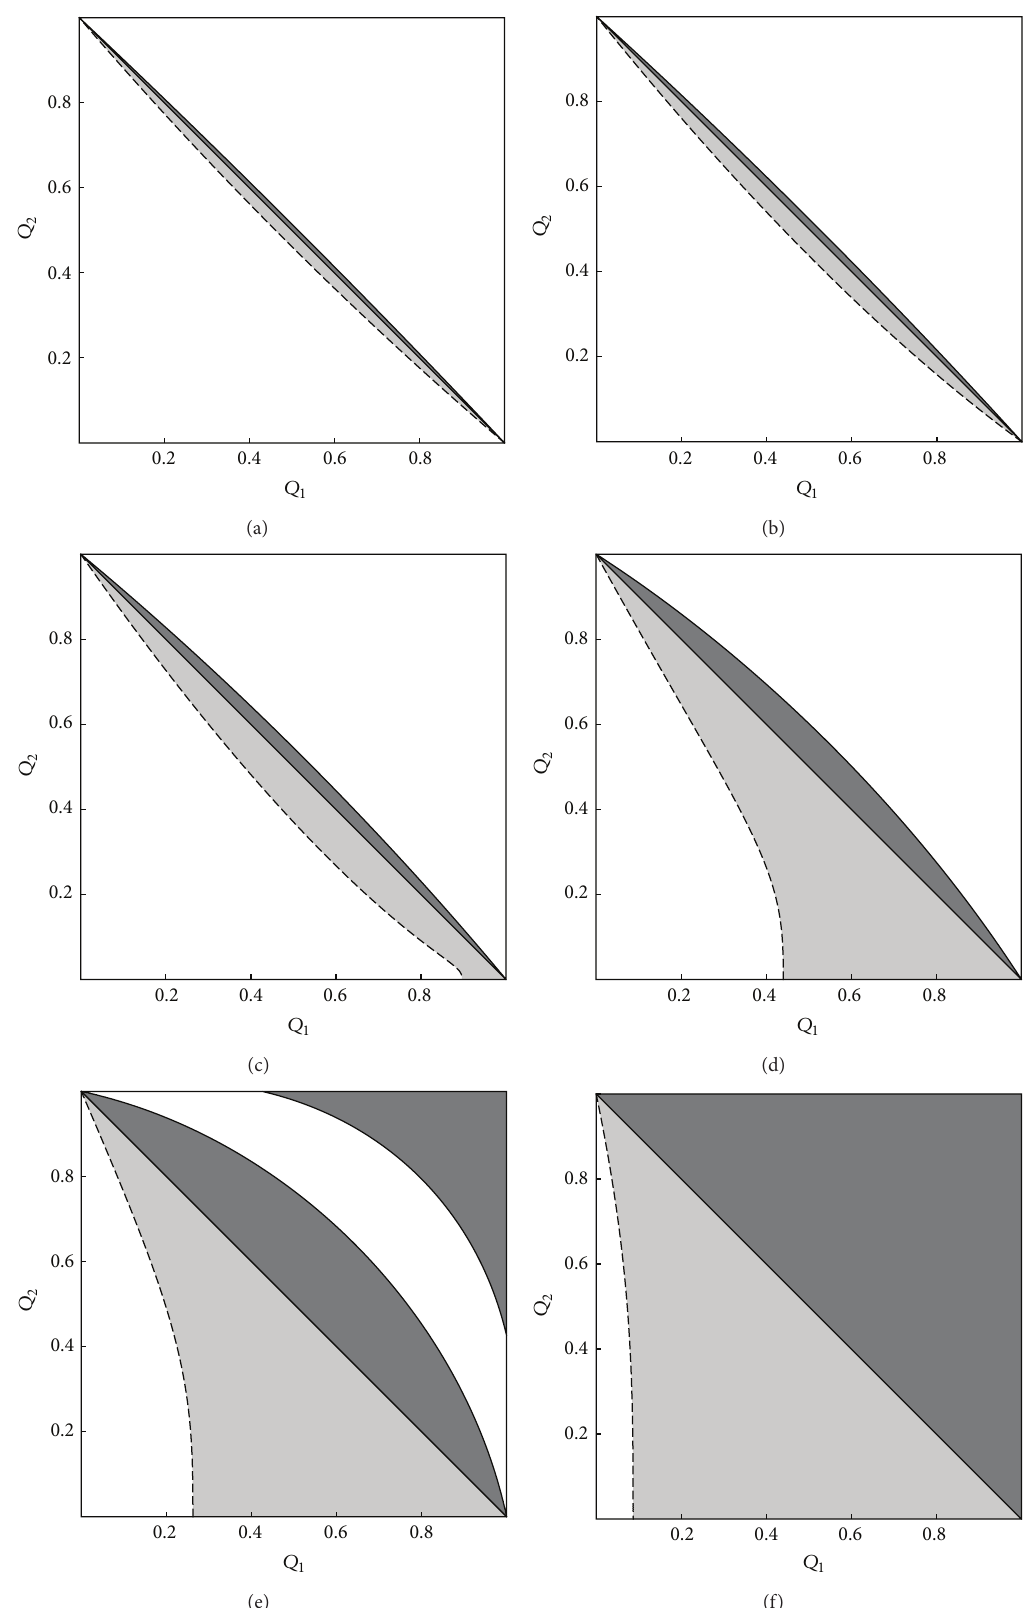
Figure 4: Stability regions of all equilibrium points in the (𝑄 1 , 𝑄 2 ) plane for 𝜔 = 1 (i.e., the photogravitational restricted three-body problem) and 𝜇 = 0 . 5, 𝜇 = 0 . 2, 𝜇 = 0 . 1, (from (a) to (c)) 𝜇 = 0 . 05, 𝜇 = 0 . 03, and 𝜇 = 0 . 01 (from (d) to